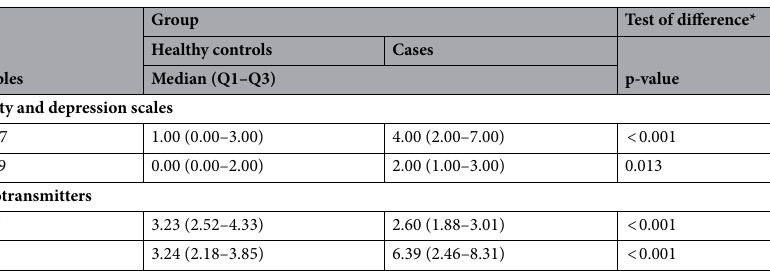
Table 2. Associations between anxiety and depression scores and serum BDNF, CRH levels in vitiligo patients and healthy controls. *—test of difference was Mann Whitney U-test. GAD-7—Generalized Anxiety Disorder 7-item Scale. PHQ-9—The Patient Health Questionnaire 9-item depression module. BDNF – Brain-derived neurotrophic factor. CRH – Corticotropin releasing hormone.